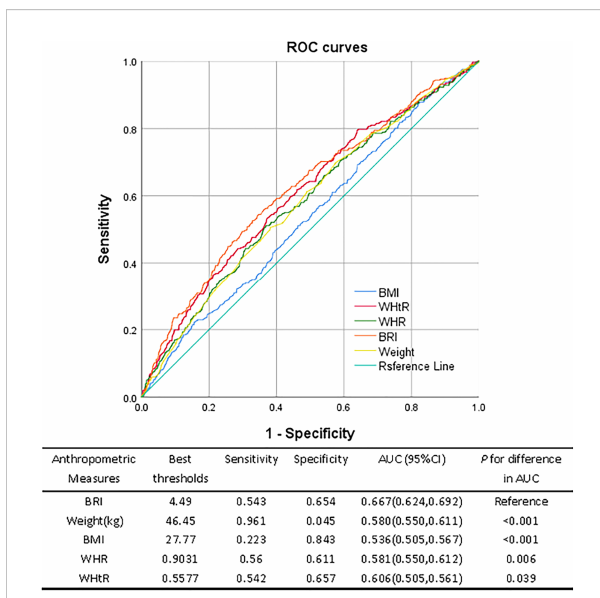
FIGURE 2 ROC curves of different anthropometric measures for discriminating low